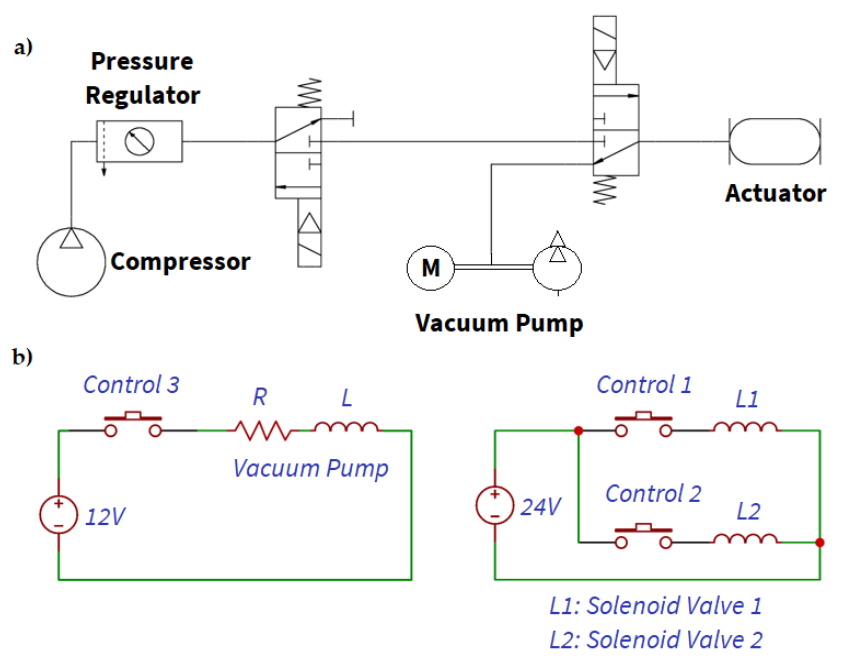
Figure 1. Pneumatic system. ( a ) Connection diagram. ( b ) Wiring diagram control. Signals 1, 2, and 3 are the cables that connect to the UR3 for control.